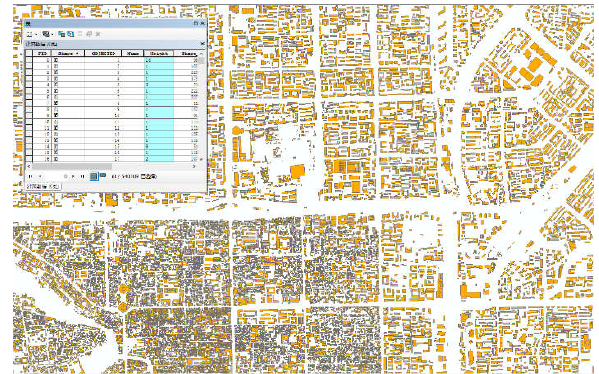
Figure 7 The Lama Temple and its surrounding buildings vector diagram (partial)